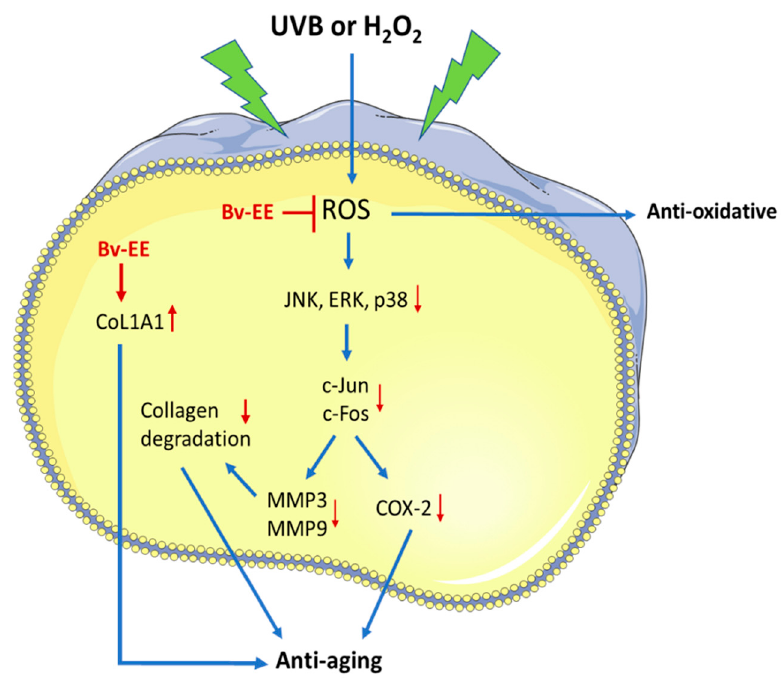
Figure 7. Schematic representation of skin protective effect of Bv-EE.